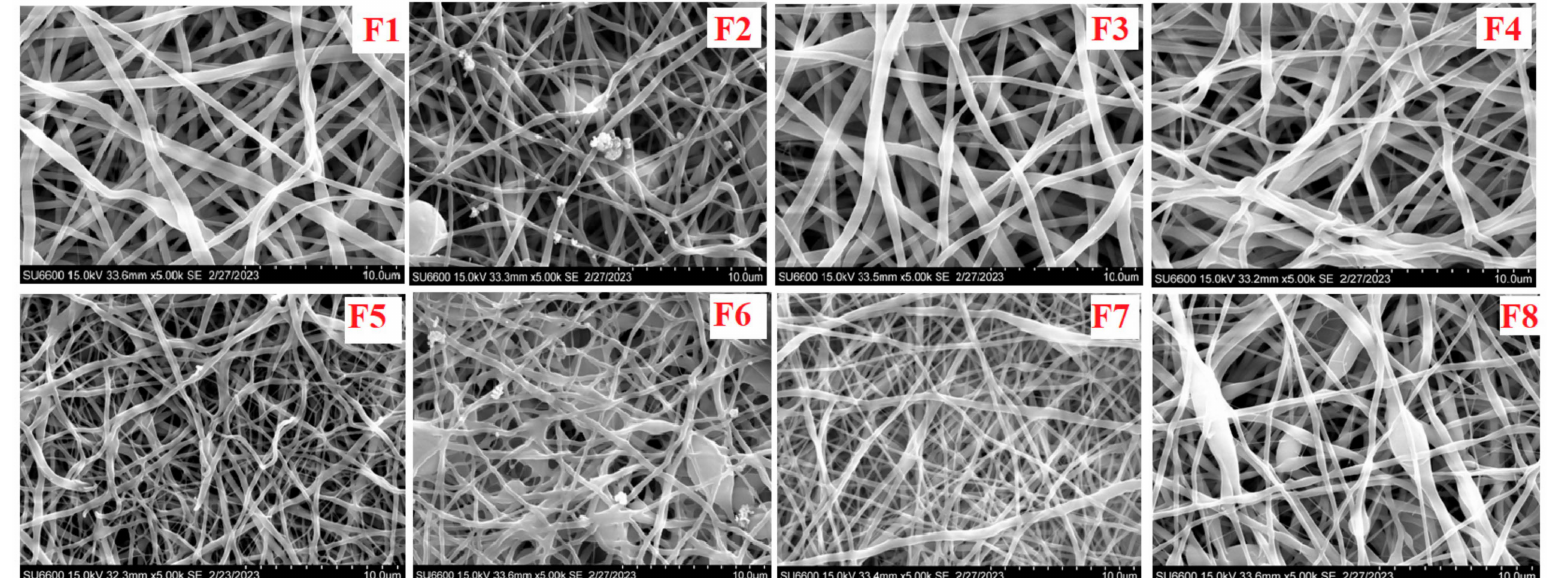
Figure 1. Scanning electron micrographs of developed scaffold formulations F1 – F8